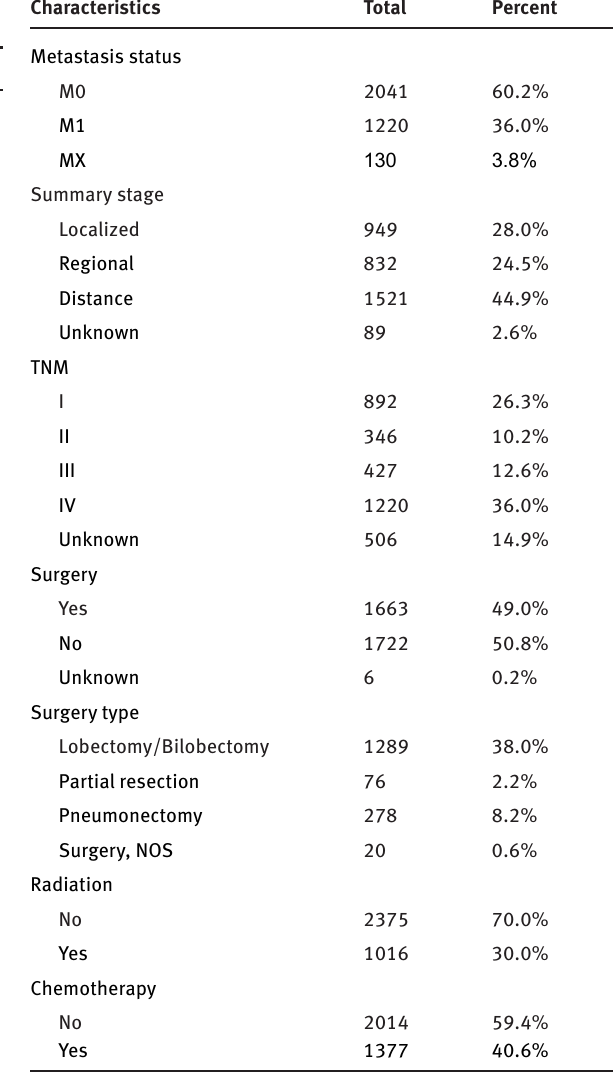
and Table 2). The overall 3-, 5- and 10-year survival rate for